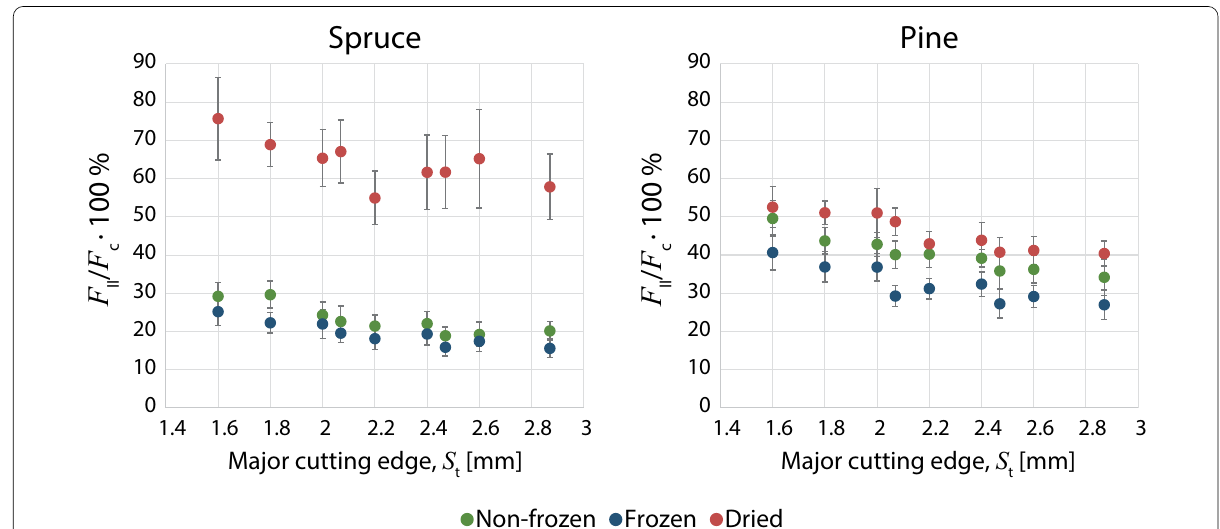
Fig. 10 The Zone II force contribution to the cutting force for different major cutting edges ( S t